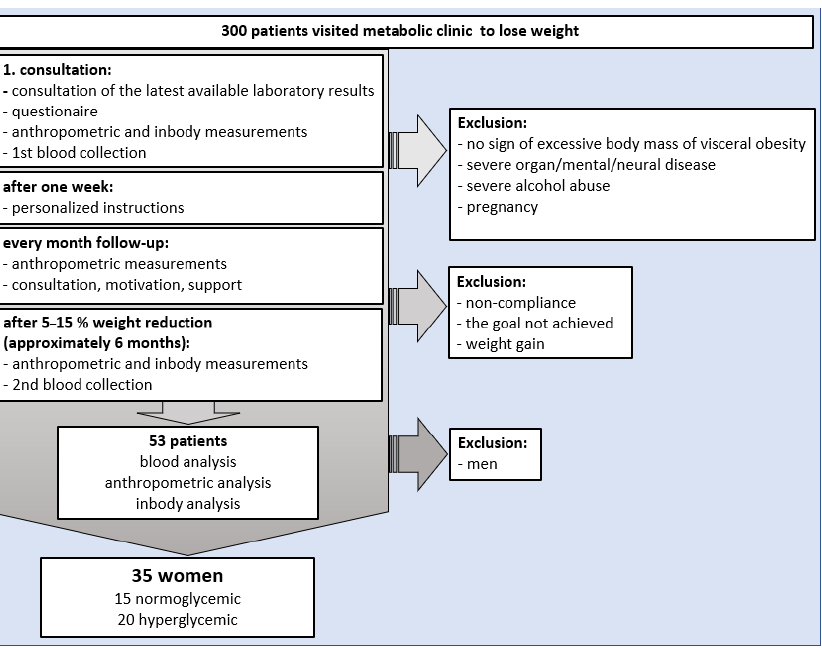
Figure 1. The flowchart of the study design.